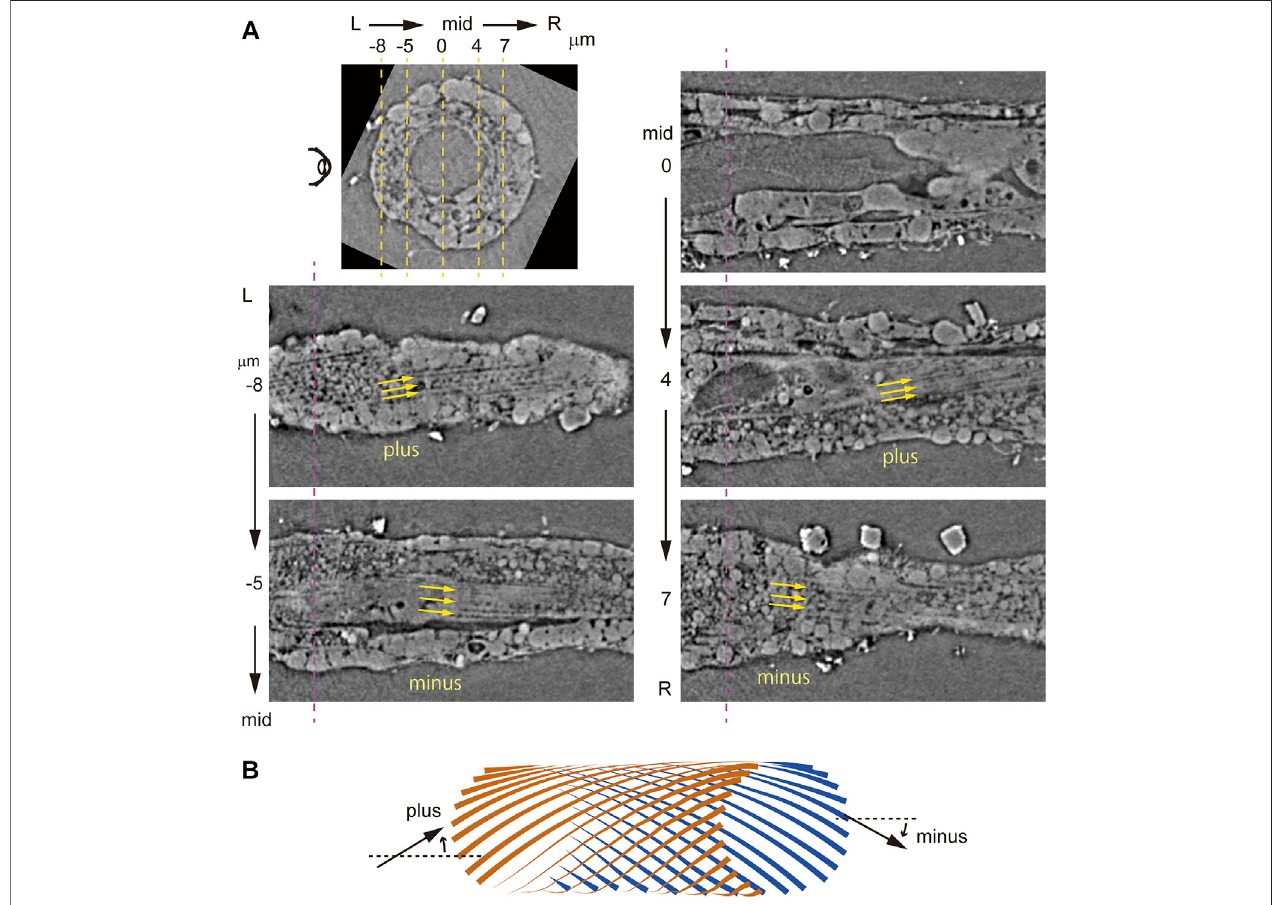
FIGURE 6 | Laboratory-based Zernike X-ray tomographic microscopy of Ciona tadpole larvae. (A) Vertical cross- and parasagittal sections. Dashed magenta and yellowlinesindicatepositionsofsections,asin Figure3 .Yellowarrowsindicatemyo fi brilorientation. (B) Schematicmicroscopicviewsinfront(brown)andback(blue)of an inferred model of left-handed helical myo fi brils. Myo fi brils are angled plus or minus relative to the longitudinal axis of the tail.